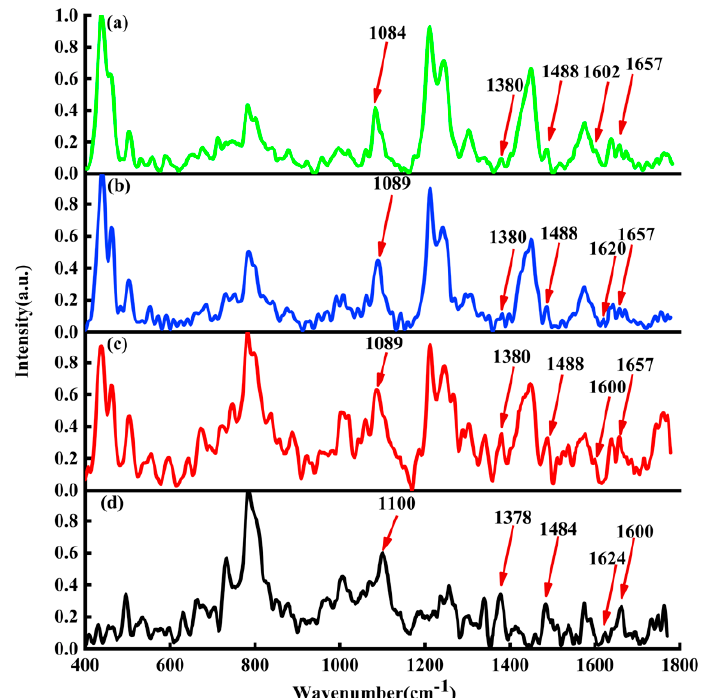
Figure 6. Raman spectra of ( a ) DNA (black line), ( b ) DOX-DNA complex (red line), ( c ) DAU-DNA complex (blue line), and ( d ) EPI-DNA complex (green line).